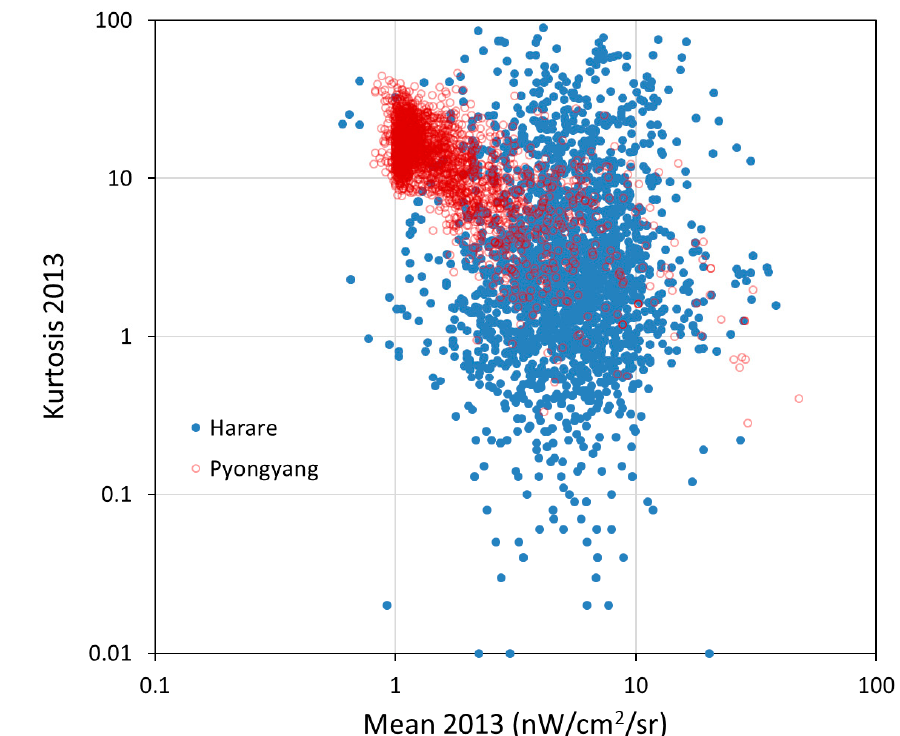
Figure 27. Kurtosis versus the mean radiance for Pyongyang and Harare. Pyongyang has an anomalously high